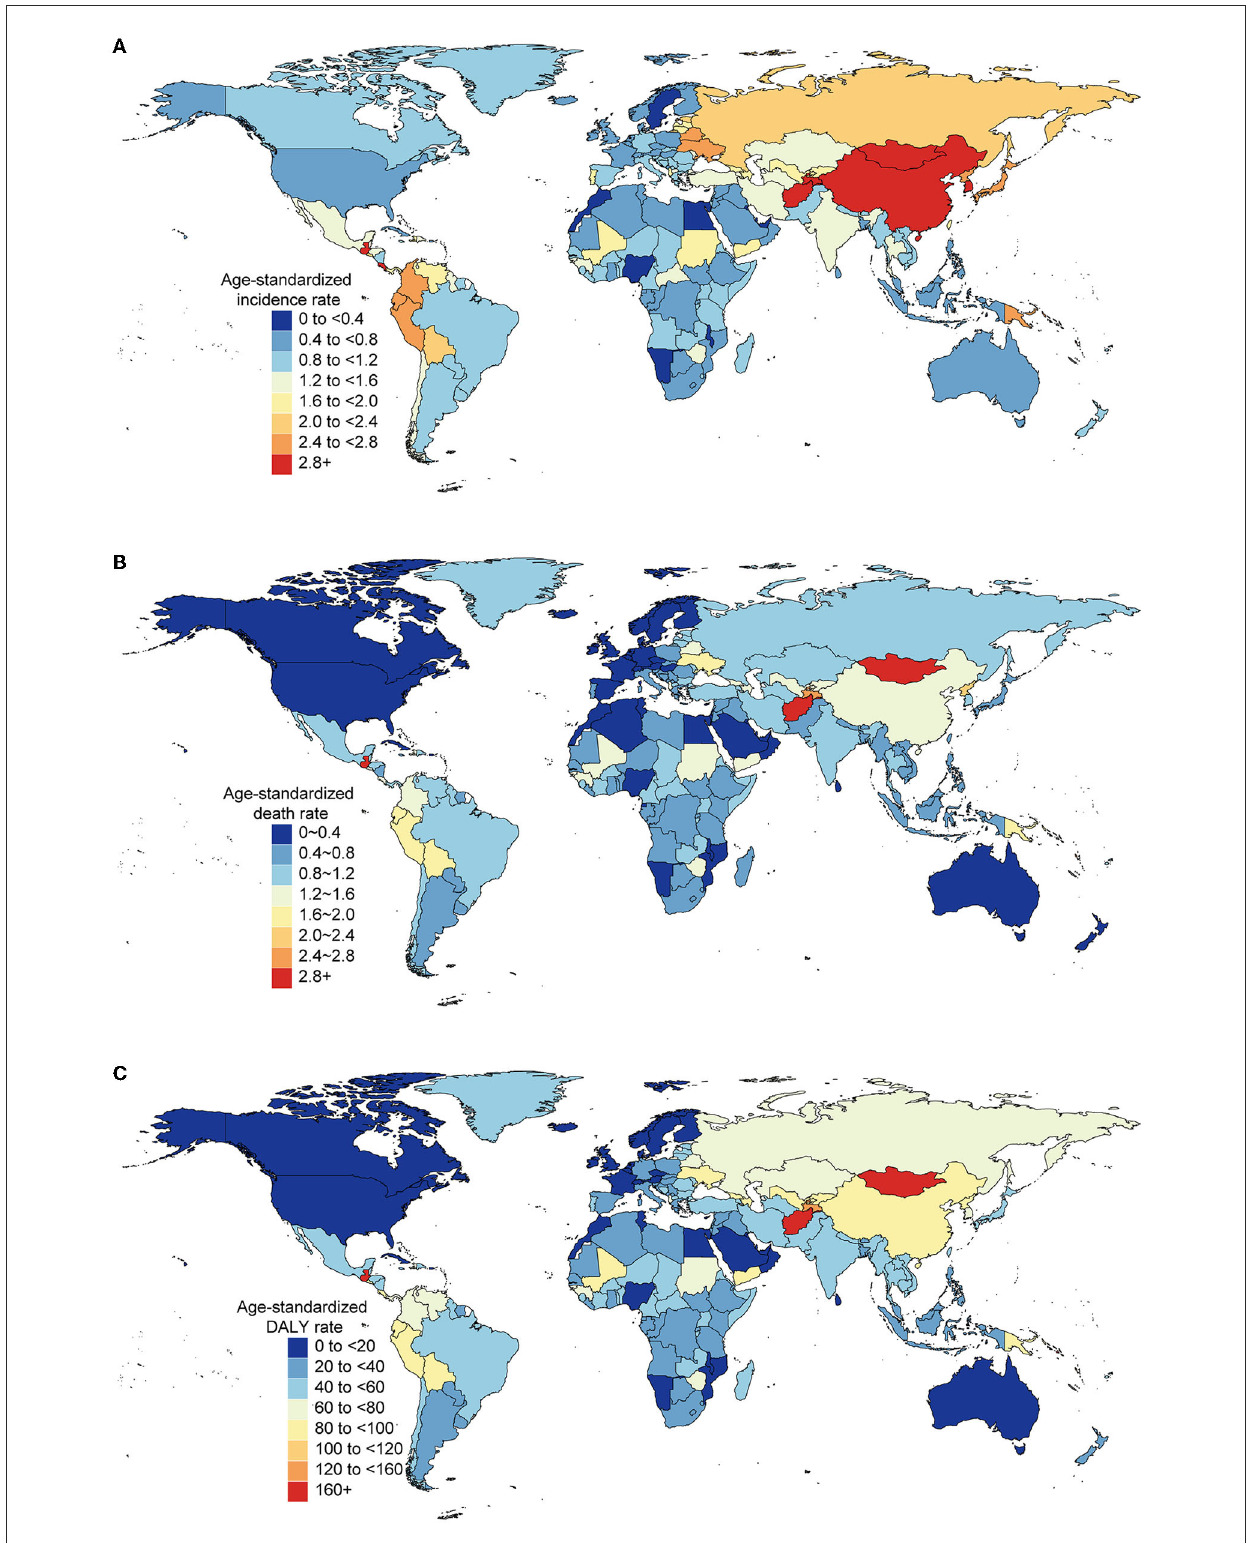
FIGURE3 Burden of AYA cancers across 204 countries and territories in both sexes, 2019. Age-standardized rates of incidence (A) , death (B) , and DALY (C) of AYA stomach cancer.